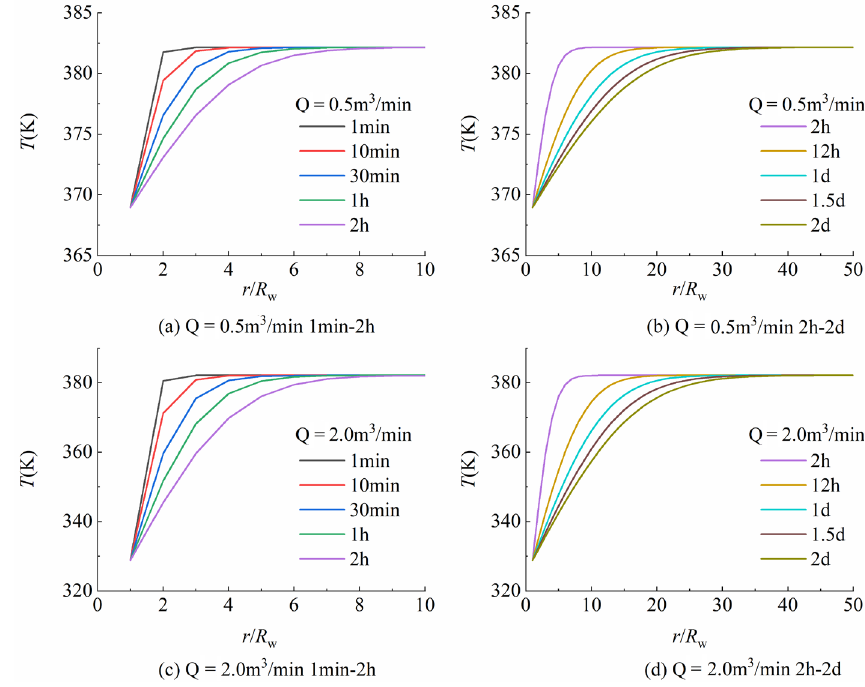
Figure 2. Distribution of formation temperature near well under different injection rate.